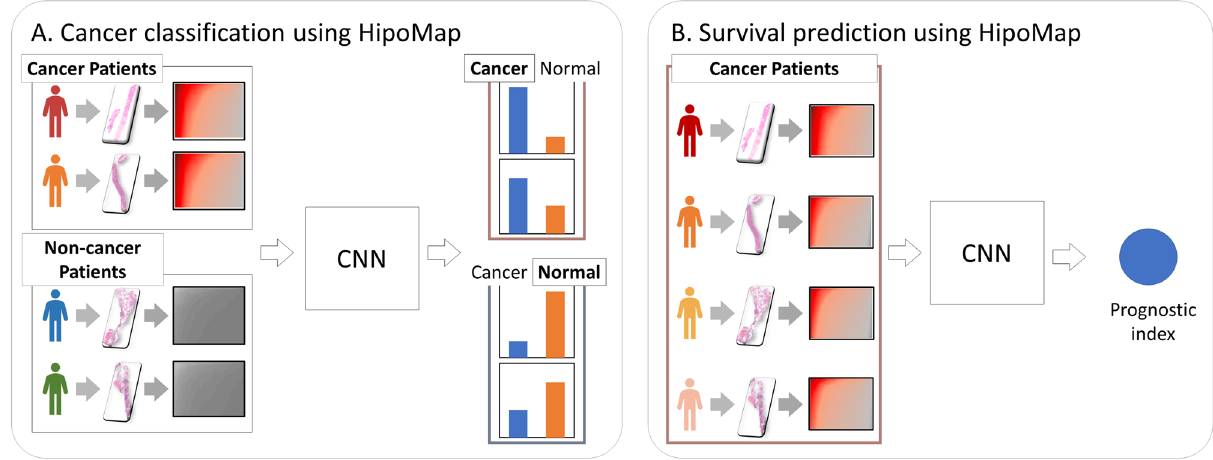
Figure 2. Applications of slide-based analysis using HipoMap but not limited to: ( A ) cancer classification and ( B ) survival analysis.